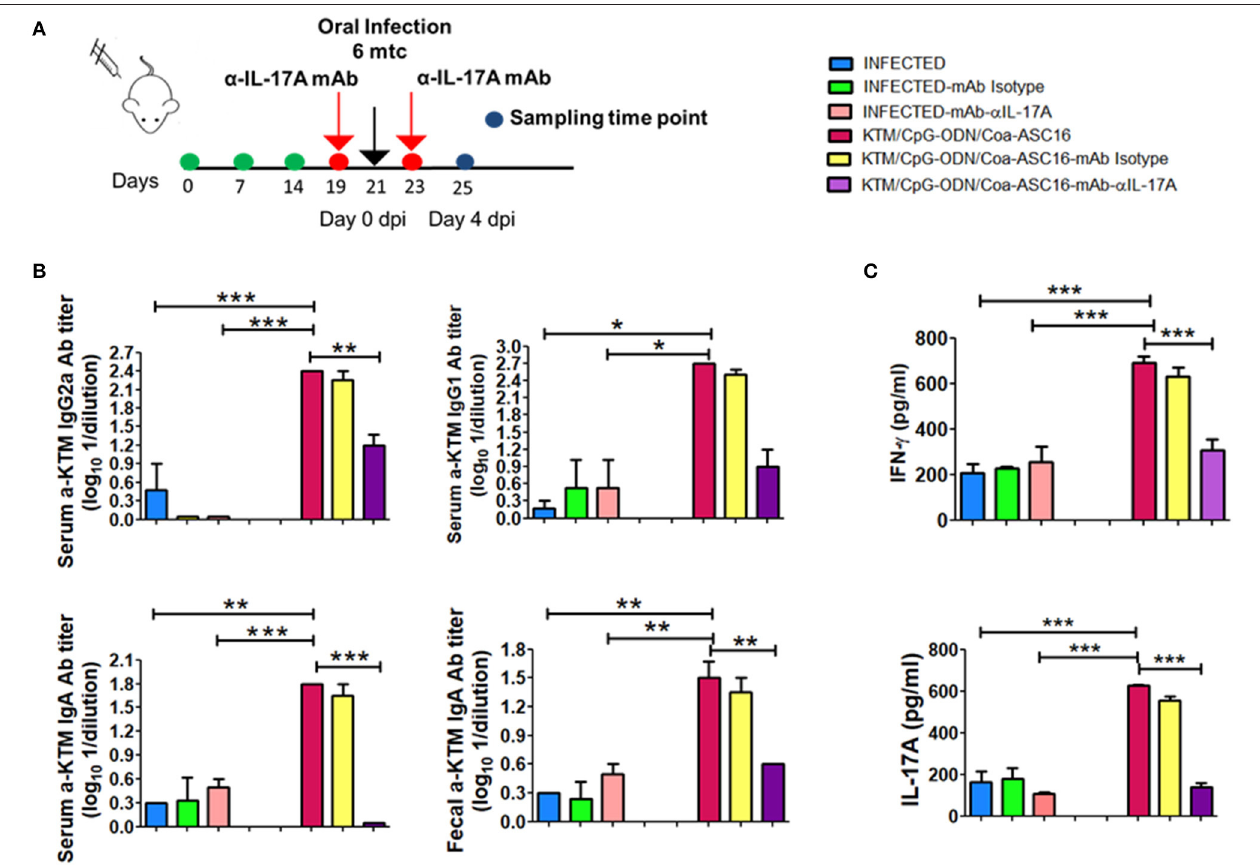
FIGURE 6 | IL-17A neutralizing reduced the immune response against FhKTM inFhKTM/CpG-ODN/Coa-ASC16 immunized mice. (A) Mice were administered with anti-IL-17A antibody and the corresponding isotype control (250 µ g i.p) 2 days before and after infections. (B) Twenty-five days after the first immunization, serum and feces samples were obtained and FhKTM antibody levels were measured by ELISA. Their titers were detected by serial serum dilution and the limit was determined by twice the value of the blanks mean. (C) Both IL-17A and IFN- γ secretion were evaluated in the splenocytes supernatant culture by ELISA. dpi: days post infection. Data are representative of two independent experiments. One-way ANOVA + Tukey’multiple comparison tests. * p < 0.05, ** p < 0.01, *** p <